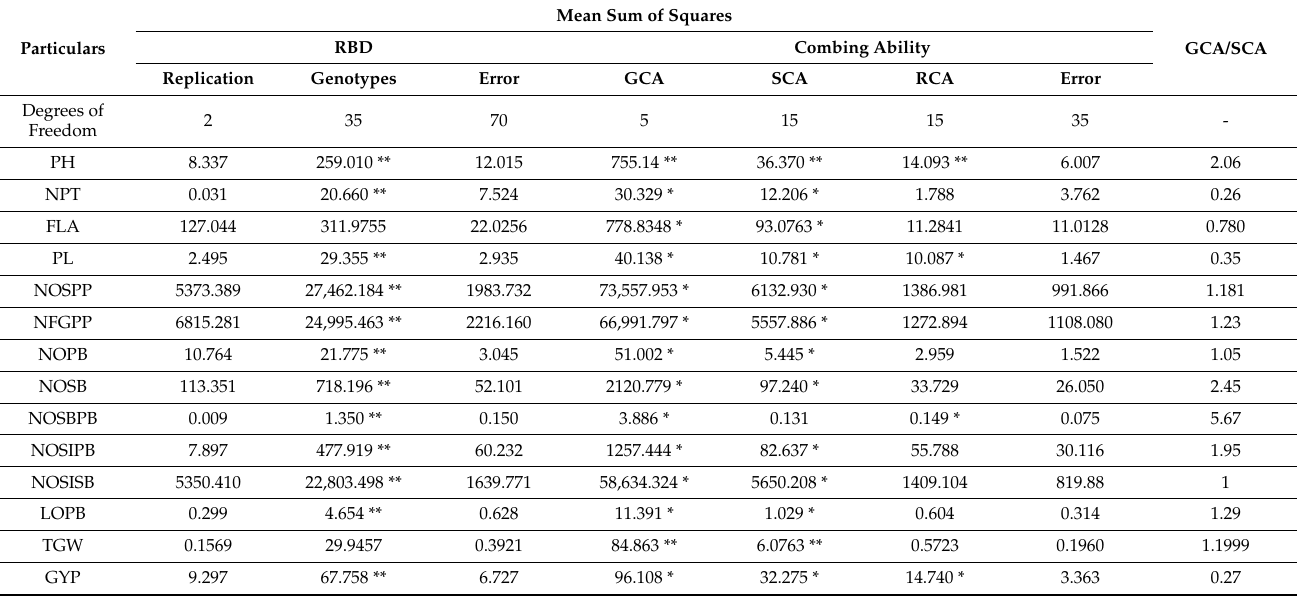
Table 6. Analysis of variance for RBD and combining ability effects for diallel analysis method I model 1.